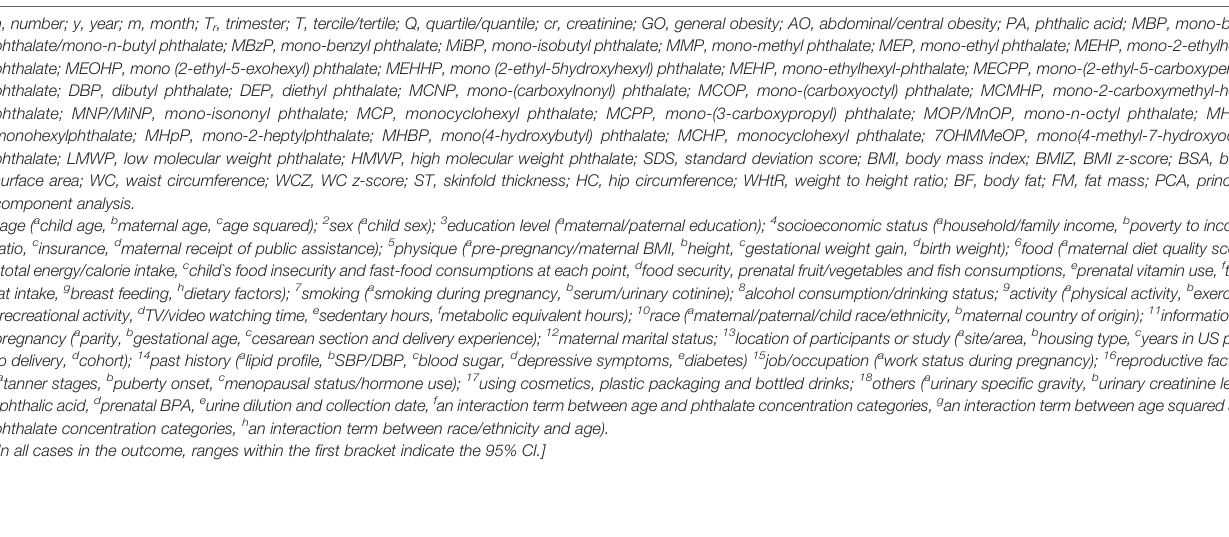
respectively, and increased BMIZ [ b =0.09 (0.003, 0.18)], among non-Hispanic blacks. (cid:129) DEHP metabolites had null associations. molar sums (sum of DEHP, LMWP, HMWP, DBP and all metabolites) were positively associated with BMI or WC after the adjustment for age and sex. (cid:129) Only MEHP and MEP showed signi fi cant positive association with BMI [ b =0.048 (0.007, 0.089) and b =0.022 (0.005, 0.040)] and WC [ b =0.038 (0.006, 0.071) and b =0.020 (0.006, 0.033)] after additional adjustment of other phthalate concentrations as covariates. (cid:129) In overweight study participants, both mean BMI and WC were signi fi cantly increased in MEP Q2 (median, 131 µg/g cr) [21.7 (20.7, 22.8) and 73.5 (70.7, 76.4) respectively], Q3 (235 µg/g cr) [23.8 (22.7, 24.8) and 79.2 (76.3, 82.0) respectively] and Q4 (948 µg/g cr) [23.5 (22.5, 24.3) and 78.8 (76.3, 81.3), respectively], compared to MEP Q1 (67 µg/g cr). Similar relationships were also found for LMWP. (cid:129) Null associations of other phthalate metabolites with anthropometric measures of obesity were observed among the children. (cid:129) In male (20 – 59 y) groups, both BMI and WC increased from Q1 to Q4 of MBzP (mean BMI=26.7, 27.2, 28.4, 29.0, p =0.0002). Mean BMI generally decreased across quartiles among adolescent girls (25.1, 23.7, 23.0, and 23.6 from the Q1 to Q4 of MEHP, p-trend =0.02) and among 20 – 59 y females (29.8, 30.2, 28.5, and 28.1, p-trend =0.02). (cid:129) Most of the coef fi cients for MEP were positive, with the exception of adolescent males (no relationship) and older females (an inverse relationship). For adolescent girls, mean BMI were 22.9, 23.8, 24.1, and 24.7 ( p-trend =0.03) with increasing quartile of metabolite concentration, and adjusted mean WC were 77.4, 79.7, 80.1, and 81.6 ( p-trend =0.02). positively associated with WC [ b =1.29 (SE: 0.34), b =1.71 (SE: 0.56), b =1.81 (SE: 0.60) and b =0.77 (SE: 0.29), respectively] after adjusted with covariates ( p ≤